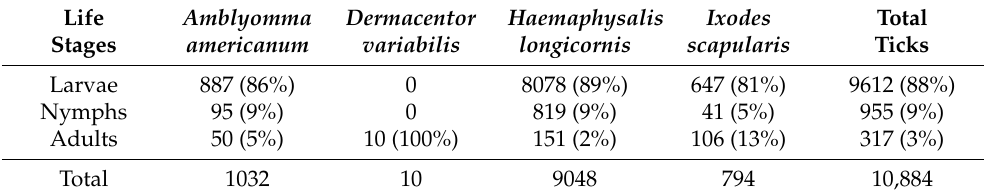
Table 1. Number of ticks per stage and species collected in ecotone areas from five sites in New Brunswick, NJ. Total proportion of each life stage is shown between parentheses for each tick species.